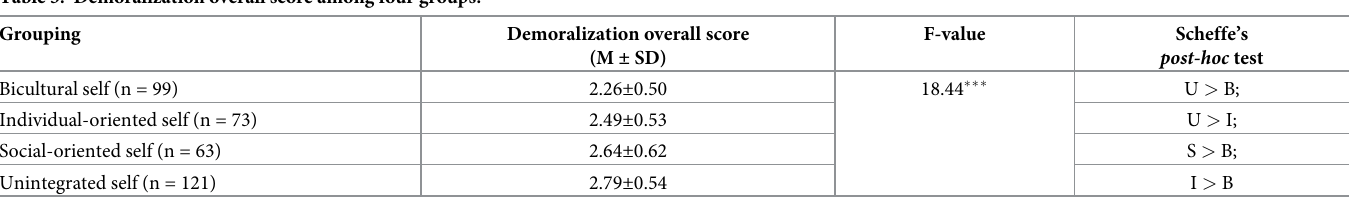
Table 3. Demoralization overall score among four